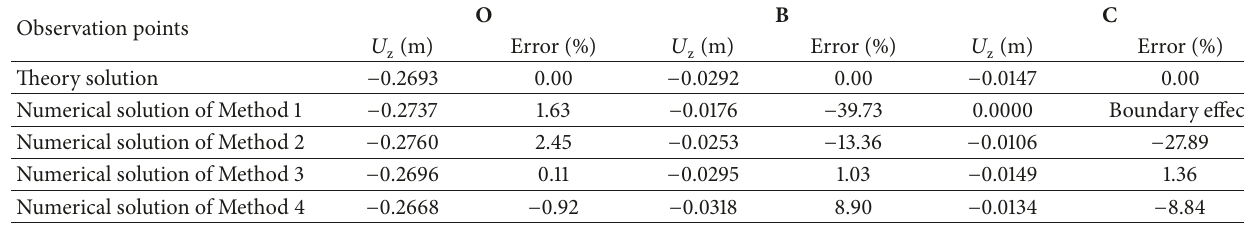
Table 2: Numerical displacements of different boundary methods and their relative errors.